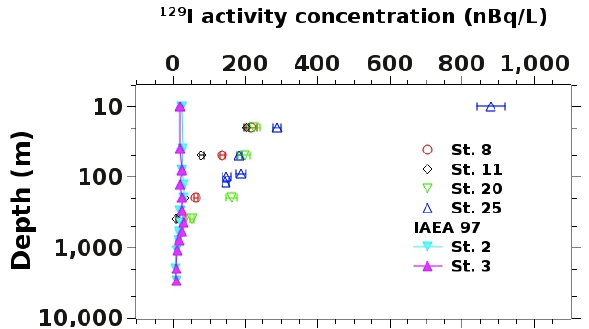
Fig. 3. A comparison of 129 I profiles as obtained from the IAEA’97 expedition (global fallout impact; Povinec et al., 2010) with the re- sults presented in this paper, which are based on analysis of seawa- ter samples collected during the KOK expedition (Fukushima im- pact) in the NW Pacific